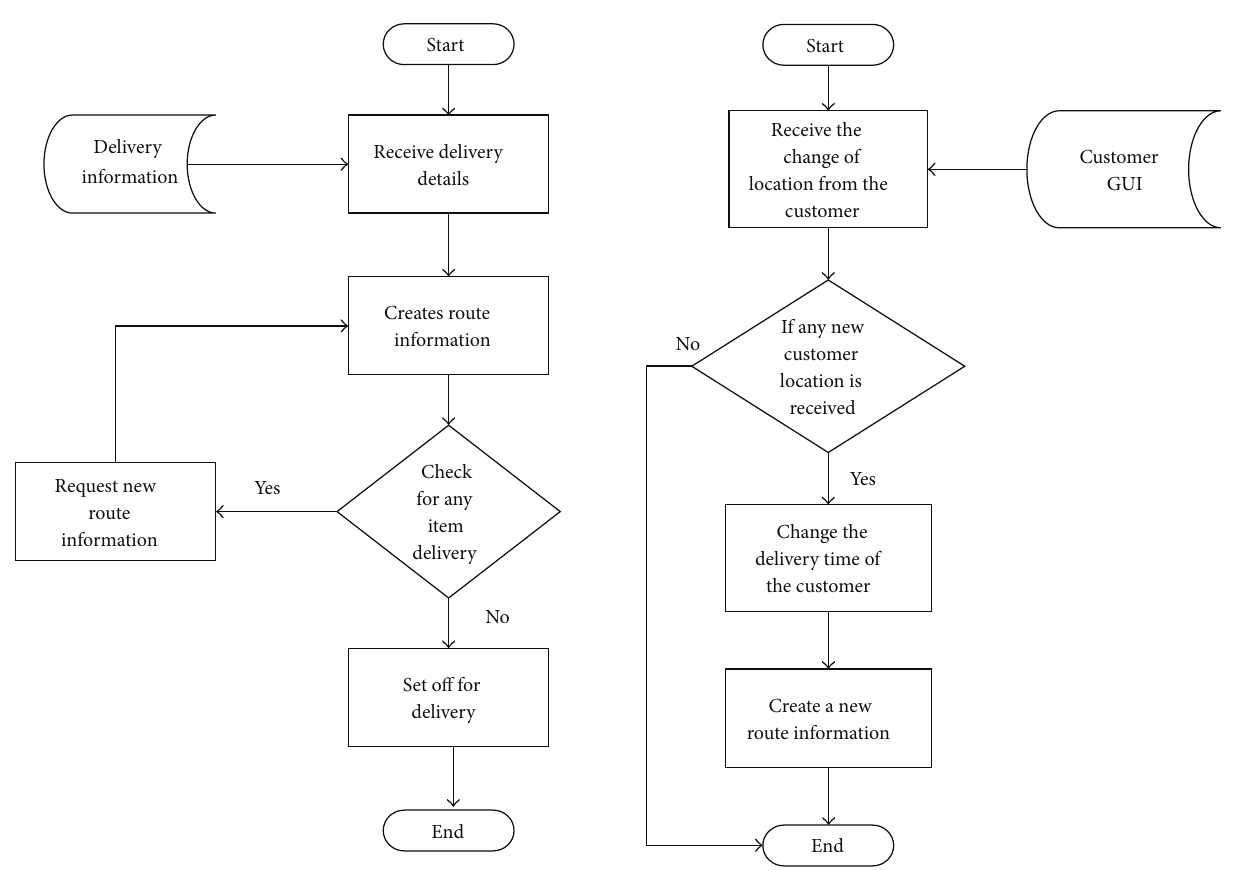
the location of the customer, and the optimal route for the delivery are obtained as shown in the Figure 7.